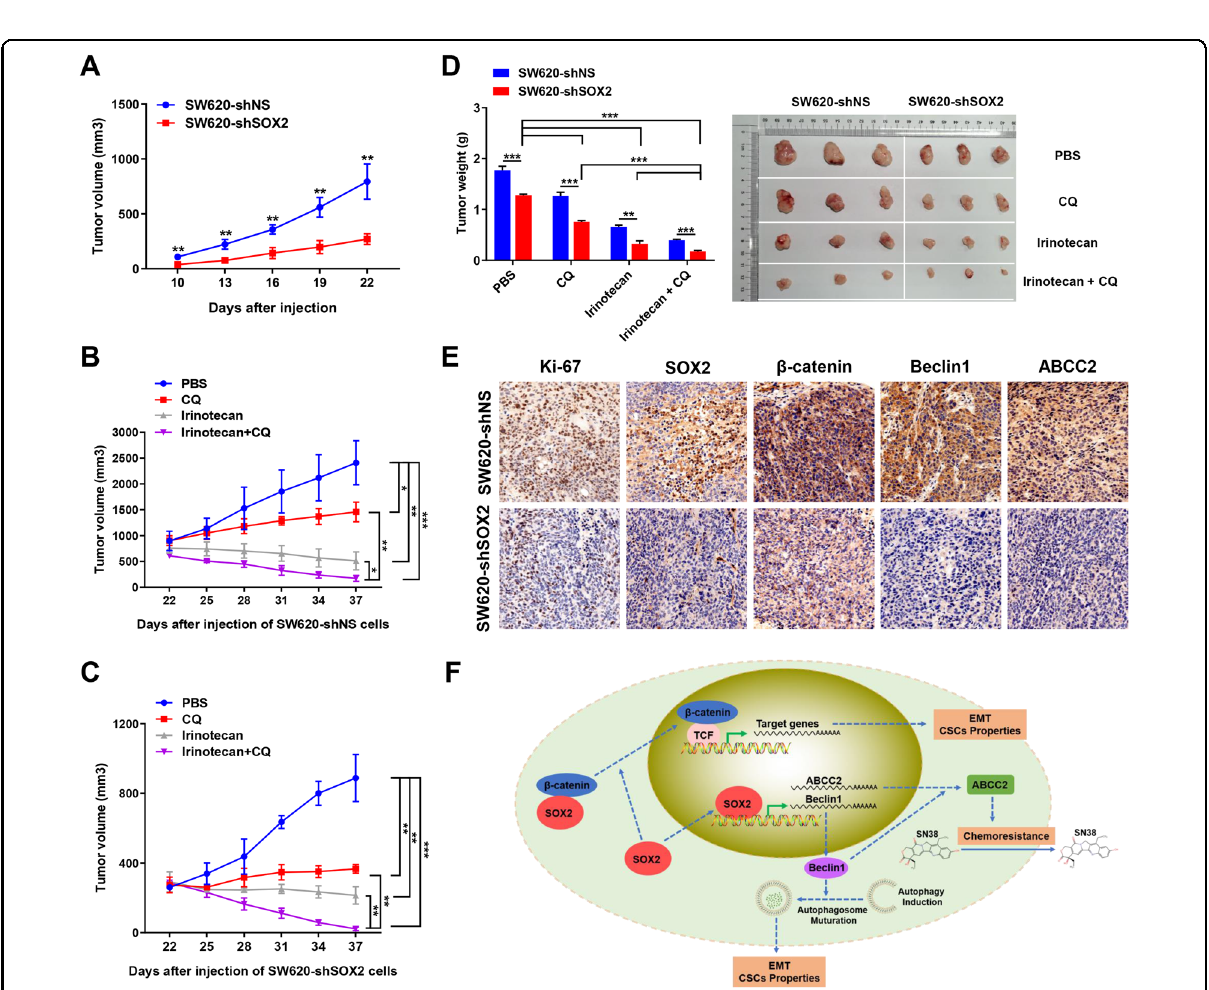
Fig. 7 Knockdown of SOX2-restrained tumor growth and chemoresistance in vivo. A – C Growth curves of xenografts with SOX2-silencing SW620 cells and control SW620 cells were plotted based on tumor volume. D Weight of xenografts was measured at the endpoint. E IHC analysis of SOX2, β -catenin, Beclin1, and ABCC2 expression in xenografts. F Schematic representation of the proposed mechanism for SOX2-induced chemoresistance, CSCs properties, and EMT in CRC. Data are shown as mean ± SEM. * P < 0.05, ** P < 0.01, *** P <